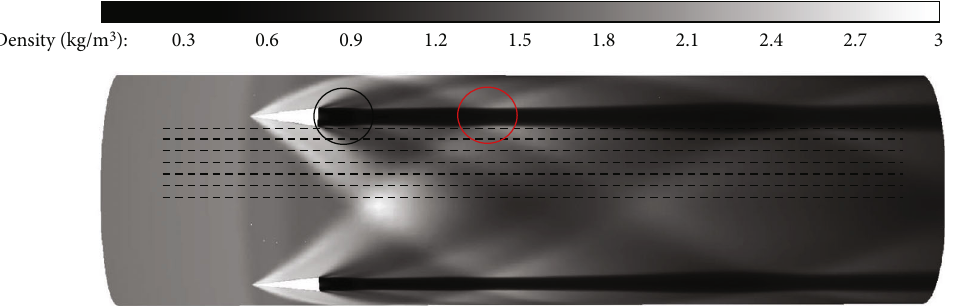
Figure 9: The distribution of the density at the surface of r = 50 mm .